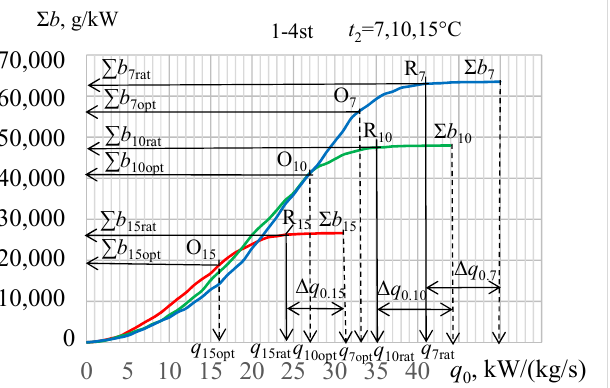
Figure 13. Annual specific fuel reduction ∑ b and its relative increments ( ∑ b − ∑ b opt )/ q 0 ·for t a 2 = 7, 10 and 15 °C: Δ q 0 — reduction of design speci fi c cooling capacity;· − ( ∑ b − ∑ b opt )/ q 0. The values of rational annual specific fuel reduction ∑ b 7rat , ∑ b 10rat and ∑ b 15rat , proceeding from the